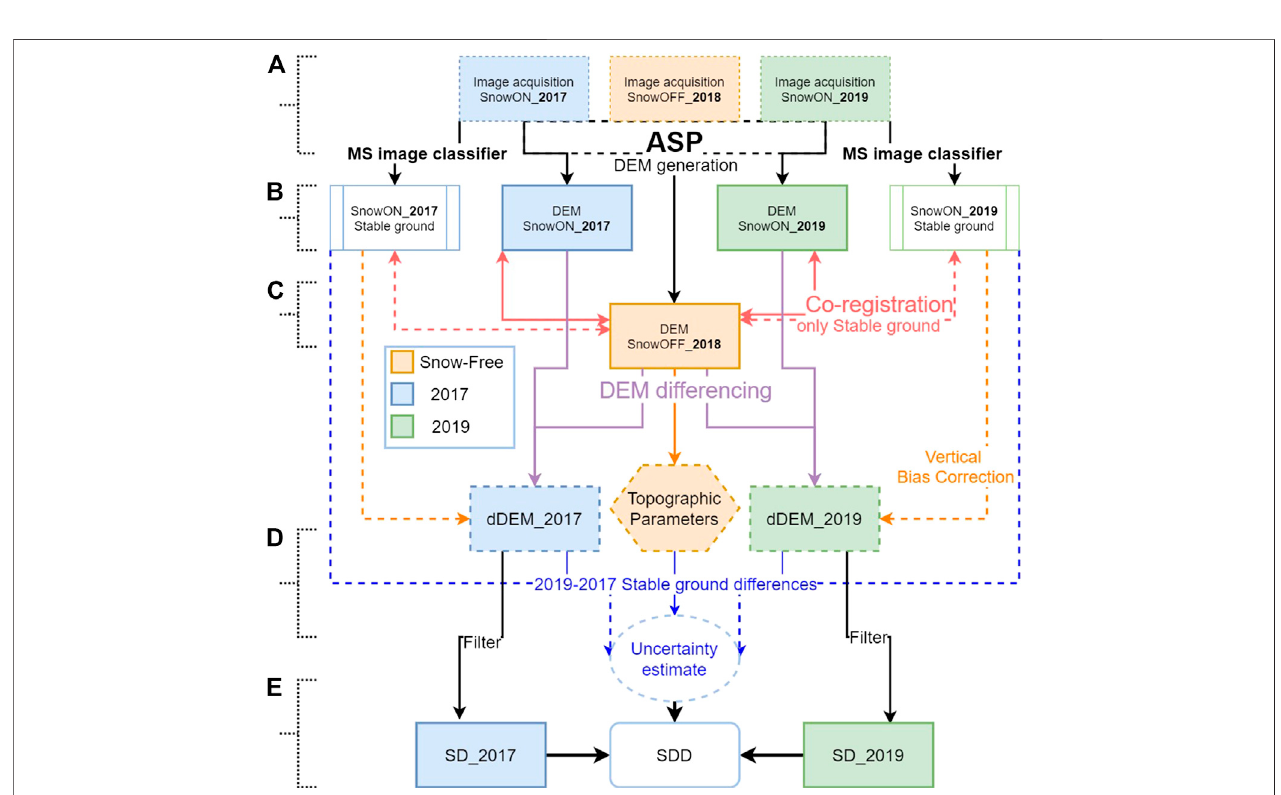
FIGURE 2 | A fl owchart of the steps taken to process Pléiades digital elevation models to assess snow depth difference (SDD) in this study. Steps (A ‒ E) are referenced in the methodology text.